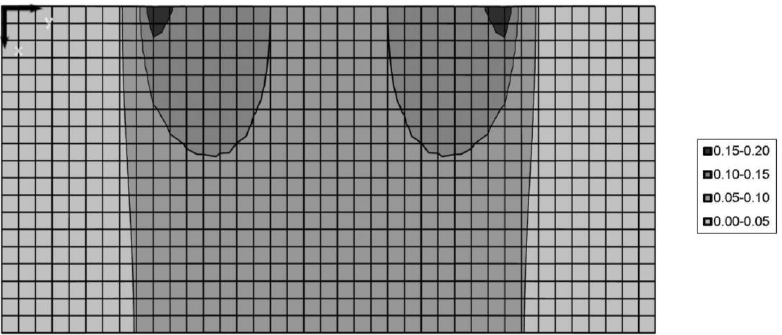
Figure 2. The absolute value of the reduced velocity field for Pe y = 100; B/D = 1; H/D = 0.1.